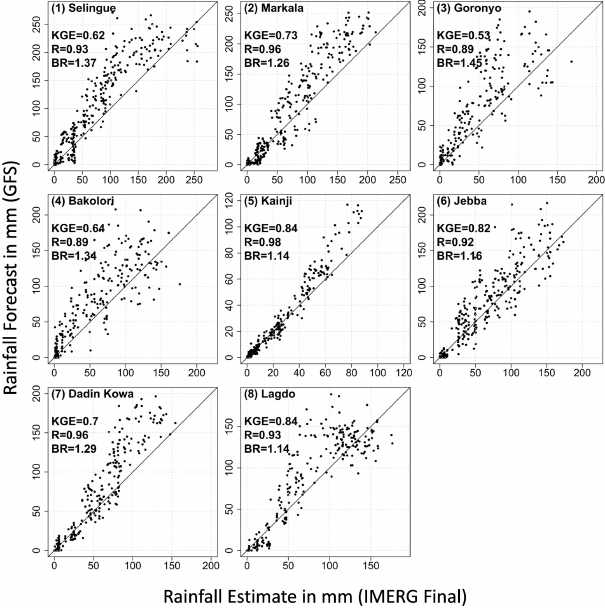
Figure 12. Scatterplot of watershed-averaged 15d accumulated pre- cipitation forecast obtained from GFS forecast against correspond- ing values from IMERG